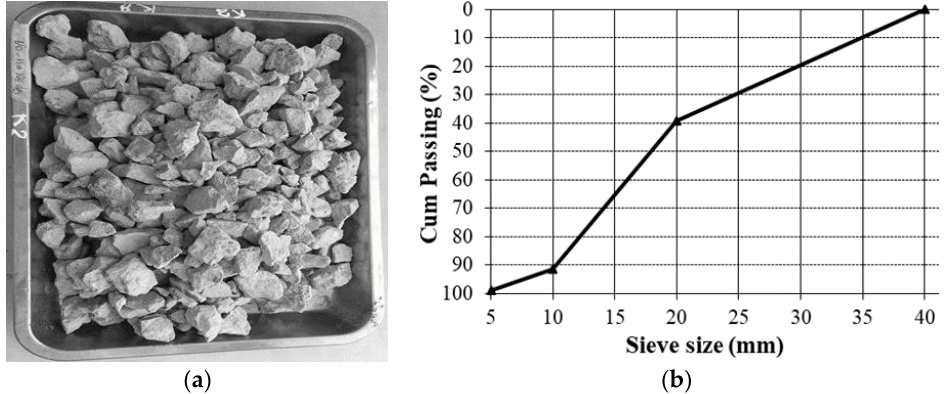
Figure 2. ( a ) Recycled coarse aggregate used and ( b ) the particle size distribution.